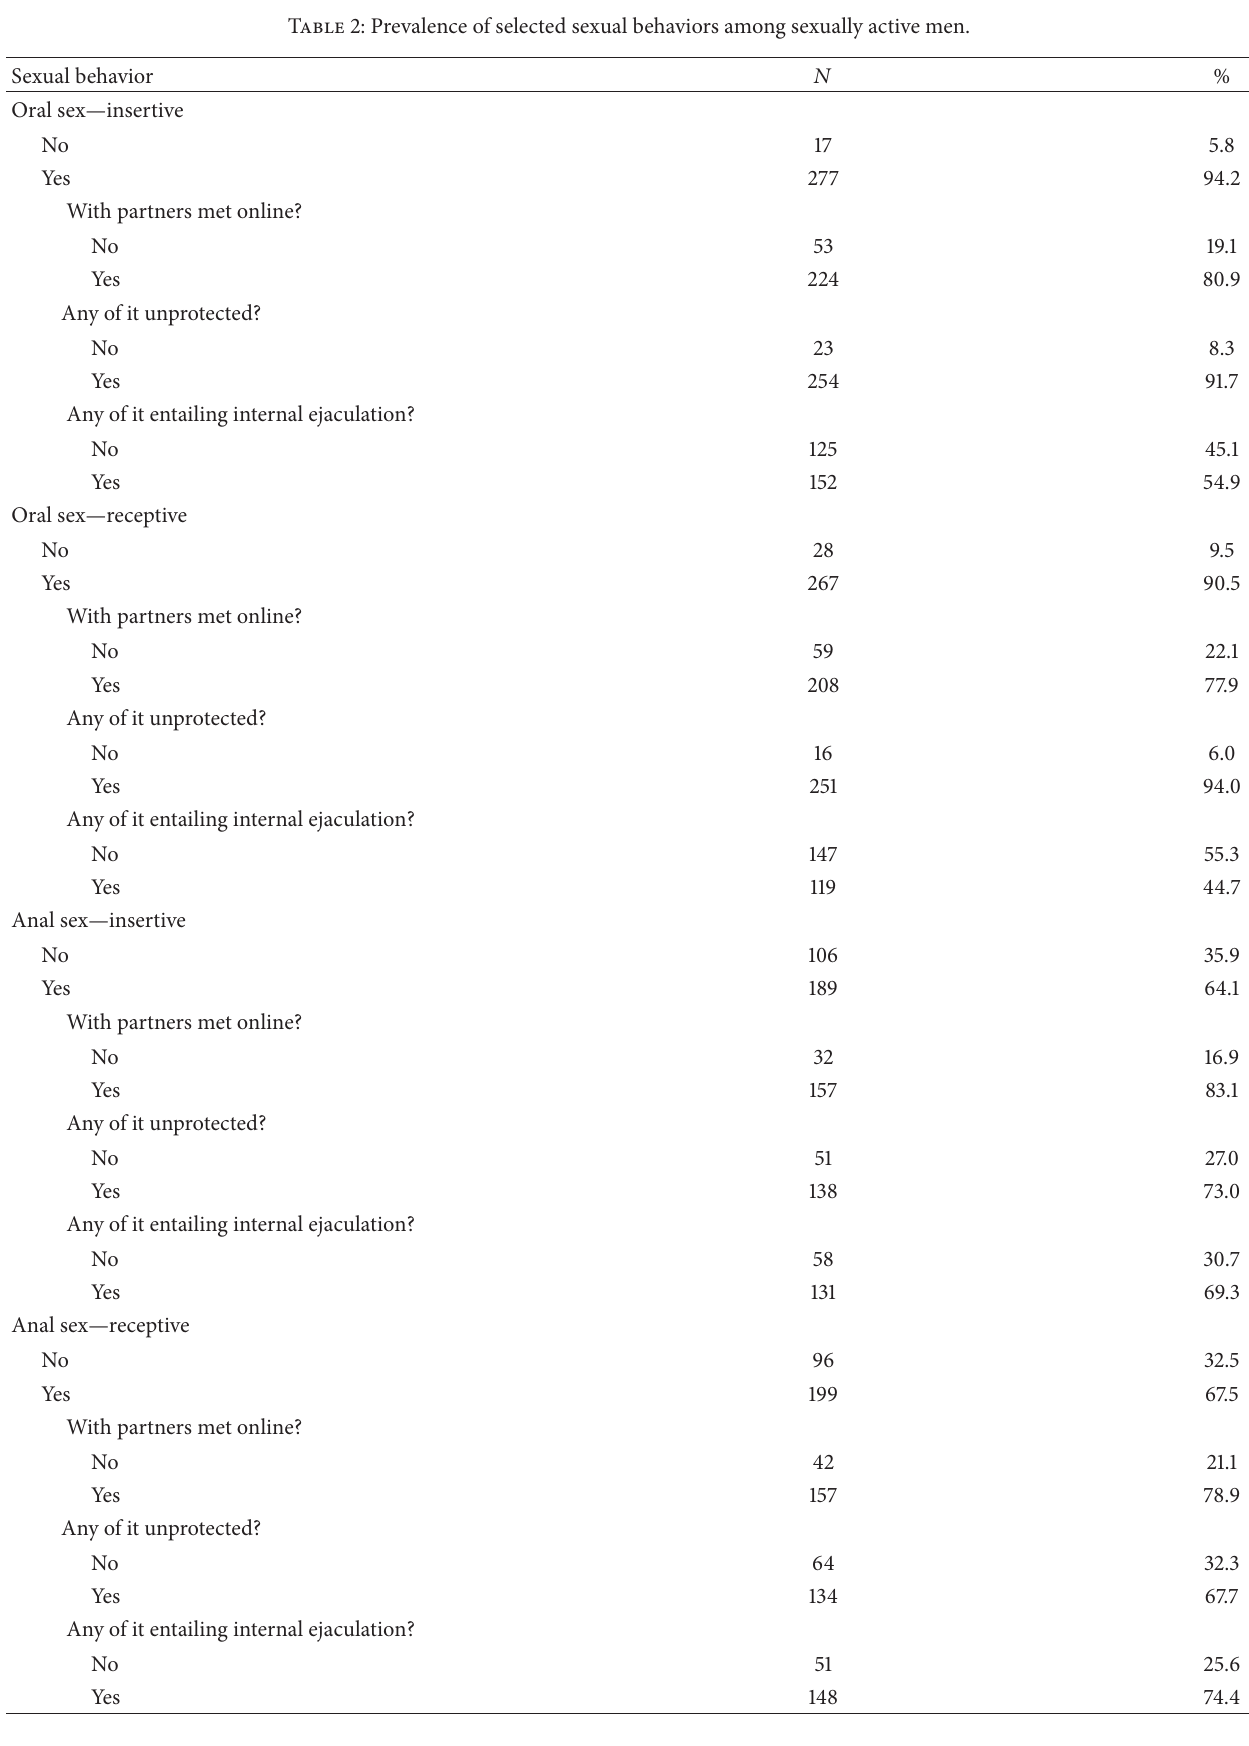
Table 2: Prevalence of selected sexual behaviors among sexually active